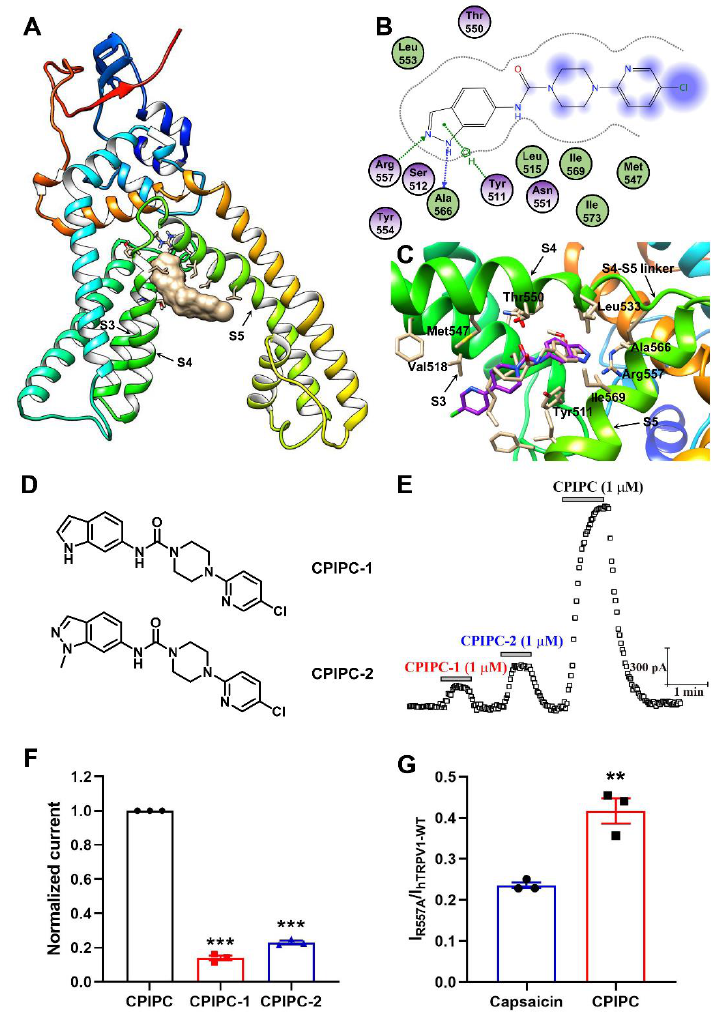
Figure 7. Identification of Arg557 as a key residue for opening of TRPV1 by CPIPC . ( A ) Location of ligand CPIPC and surrounding key residues in the crystal structure of r TRPV1 between S4 and S4 – S5 linker (PDB: 5IRX). The surface of CPIPC was shown in gray, and the surrounding residues were shown in stick. ( B ) Molecular interactions between CPIPC and related residues of r TRPV1. Green and blue arrows: hydrogen bonds. ( C ) Overlap of CPIPC (purple) and capsaicin (cream) in the bind- ing pocket of r TRPV1. ( D ) Chemical structure of CPIPC derivatives CPIPC-1 and CPIPC-2 . ( E ) Time course of TRPV1 currents in the presence and absence of CPIPC derivatives CPIPC-1 (1 μM) and CPIPC-2 (1 μM) recorded at +100 mV on h TRPV1-expressing HEK-293 cells. ( F ) The comparison of h TRPV1 current in response to CPIPC , CPIPC-1 and CPIPC-2 (1 μM) ( n = 3). ***, p < 0.001. ( G ) The comparison of h TRPV1- WT and R557A mutant currents in response to capsaicin (1 μM) and CPIPC (1 μM) ( n = 3). **, p < 0.01.